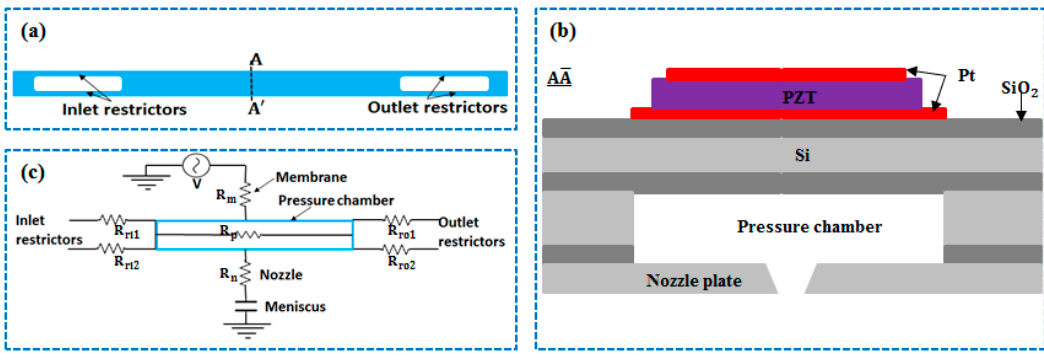
Figure 2. ( a ) Top view, ( b ) cross-sectional view, and ( c ) electrical representation of a D-RPIP design.